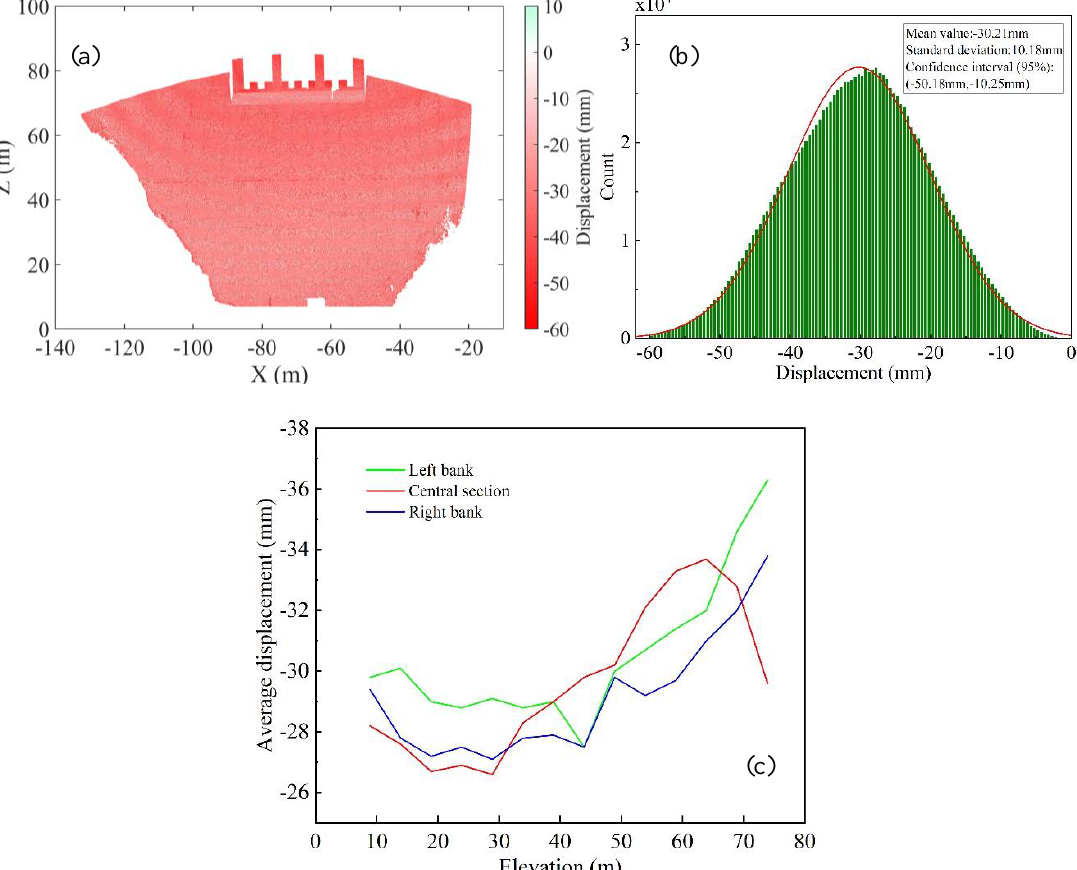
Figure 10. Results of dam displacement changes by point cloud to point cloud (C2C). ( a ) Cloud map of dam displacement variation distribution; ( b ) statistical histogram of displacement changes; and ( c ) average displacement changes of different parts of the dam with different elevations.